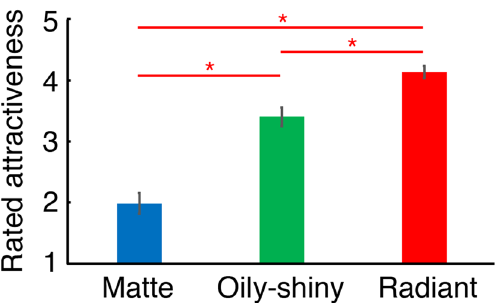
Figure 3. Rated attractiveness of faces with matte, oily-shiny, and radiant skin. Error bars indicate ± 1 SEM across subjects. * p < 0.05. Values of the effect size measures η G2 and ω G2 of all skin reflection types were 0.647 and 0.631, respectively 140,141 . Hedges’ g av 139 was 2.088, 1.348, and 3.671, for oily-shiny vs. matte, radiant vs. oily-shiny, and radiant vs. matte, respectively.